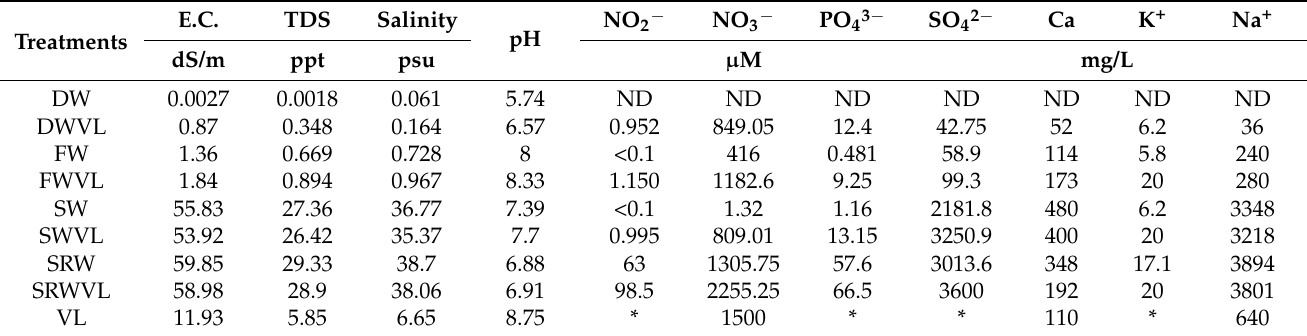
Table 1. Physico-chemical analyses of water quality variables of treatments.